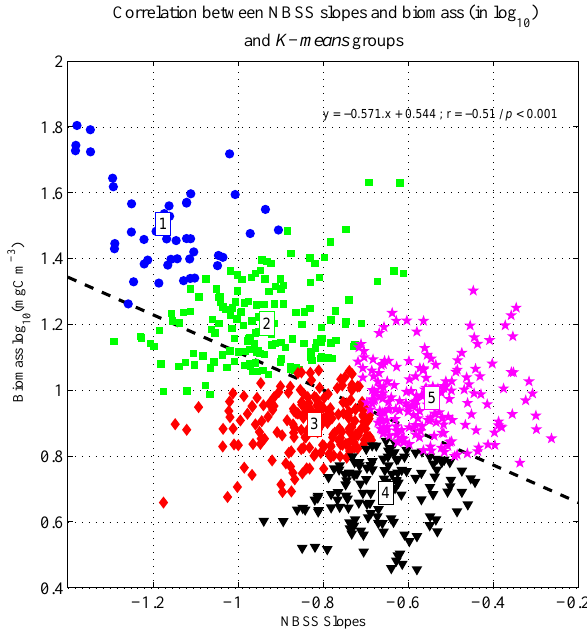
Figure 10. Correlation between slopes and the biomass computed as the integration of the log-linear NBSS in the range of 0.2–2mm ESD. The correlation (Pearson) is significant with a r = − 0 . 51. Result of five groups of K means clustering based on estimated slope and biomass is shown with different colors and shapes. Group 1: blue circles, group 2: green squares, group 3: red dia- monds, group 4: black triangles and group 5: pink stars.